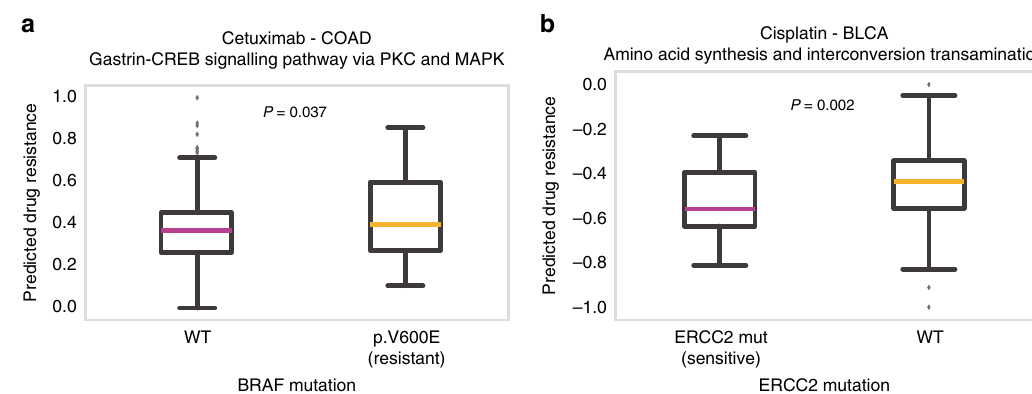
Fig. 5 Association of predicted biomarkers with known biomarkers from independent molecular datasets. a Predicted drug responses (IC 50 values; see “ Methods ” ) for colorectal tumors based on cetuximab responses that were trained from colorectal organoid models, using only transcriptomic data. The “ Gastrin-CREB signaling pathway via PKC and MAPK ” pathway was used to measure predicted drug resistance. Predicted drug resistance of 328 BRAF wild-type and 47 BRAF V600E mutated colorectal cancer (COAD) patients are displayed. The BRAF V600E mutation status correlated with predicted drug resistance. Statistical signi fi cance was measured by a one-sided Mann – Whitney U test. b Predicted drug resistance in cisplatin-treated bladder cancer (BLCA) patients. Predicted drug resistance was calculated using the “ amino acid synthesis and interconversion ” pathway. Predicted drug resistance of 367 ERCC2 wild-type and 37 ERCC2-mutated bladder cancer patients are displayed. Boxplot displays median value, interquartile range (IQR) as bounds of box and whiskers extending to upper/lower quartile ± IQR × 1.5. Statistical signi fi cance was measured by a one-sided Mann – Whitney U